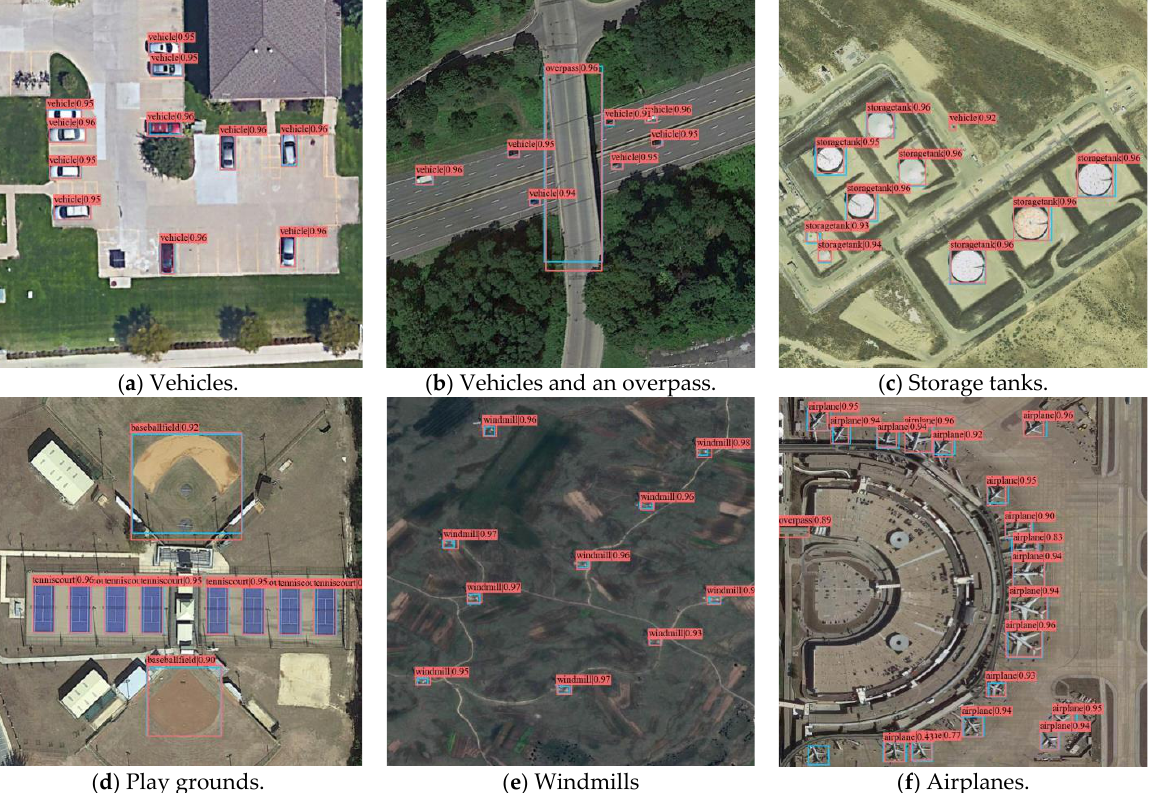
Figure 8. Qualitative inference results on the DIOR data set.